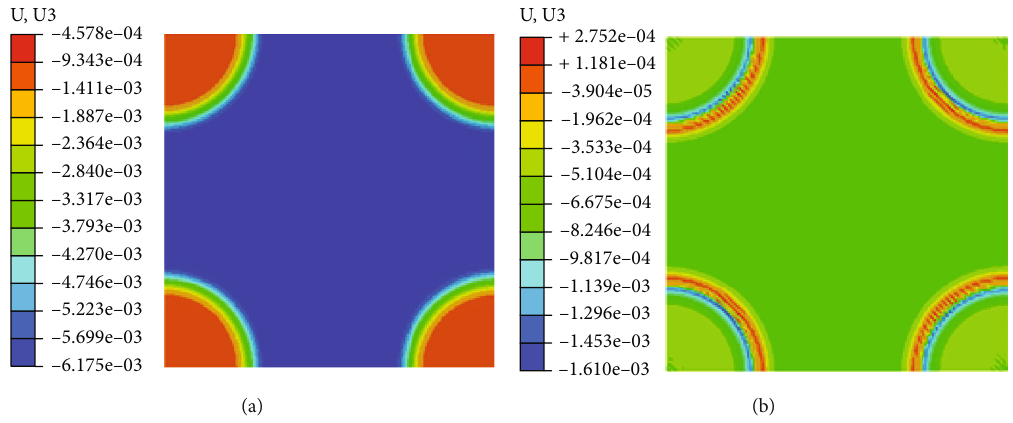
Figure 12: Displacement cloud images of Z direction of the upper slab (a) and lower slab